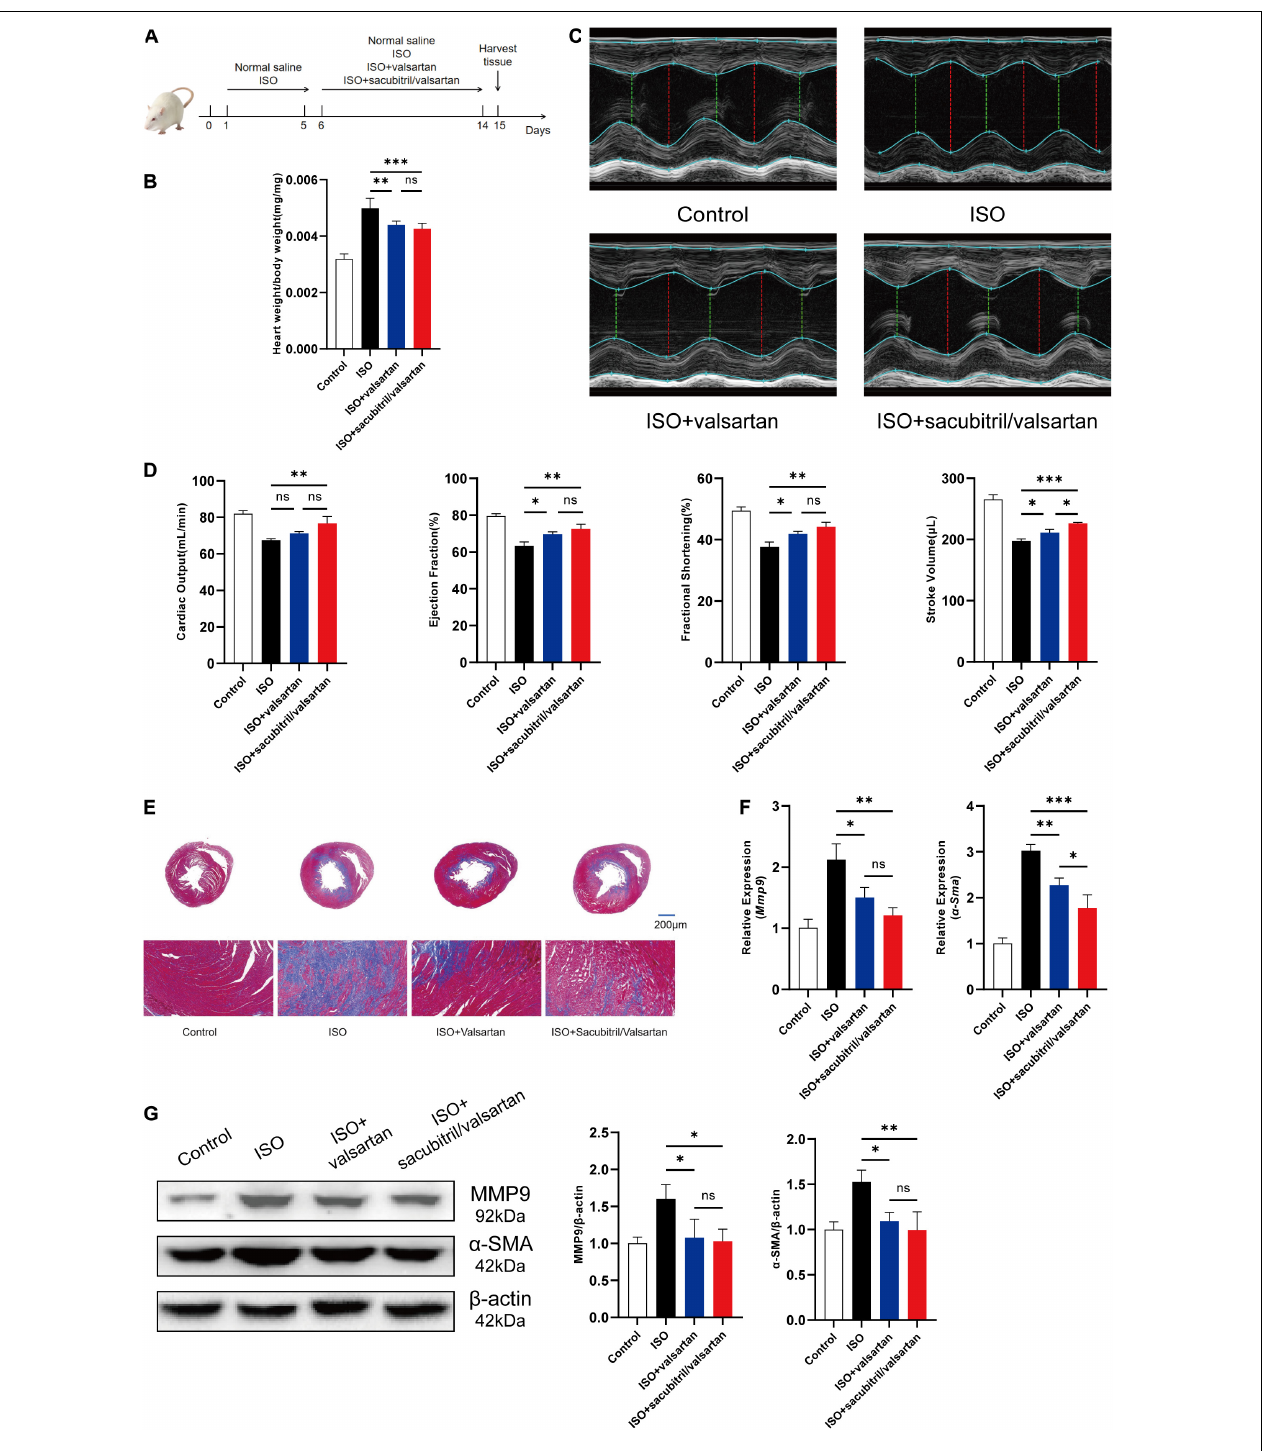
FIGURE 1 | Sacubitril/valsartan effectively protected cardiac function and ameliorated cardiac fibrosis induced by ISO in rats. (A) The flow chart of the cardiac fibrosis model and drug treatment in animal experiment. (B) Heart to body weight ratio of rats in the control group, the ISO group, the valsartan group and the sacubitril/valsartan group. (C) On the 15th day of the experiment, the heart function of rats was measured by echocardiography . (D) Cardiac output, ejection fraction, fractional shortening and stroke volume were analyzed and calculated according to the results of echocardiography. (E) Masson trichrome staining of heart tissue sections of rats. Scale bar = 200 µ m. (F) mRNA expression levels of Mmp9 and α -Sma in the left ventricular apexes of rats. (G) Protein levels of MMP9 and α -SMA in the left ventricular apexes of rats. The data presented are mean ± SD. n = 5/group. 18S RNA was used as the internal reference gene and β -actin was used as the internal reference protein for normalization and statistical analysis. ∗∗∗ P < 0.001, ∗∗ P < 0.01, and ∗ P < 0.05.